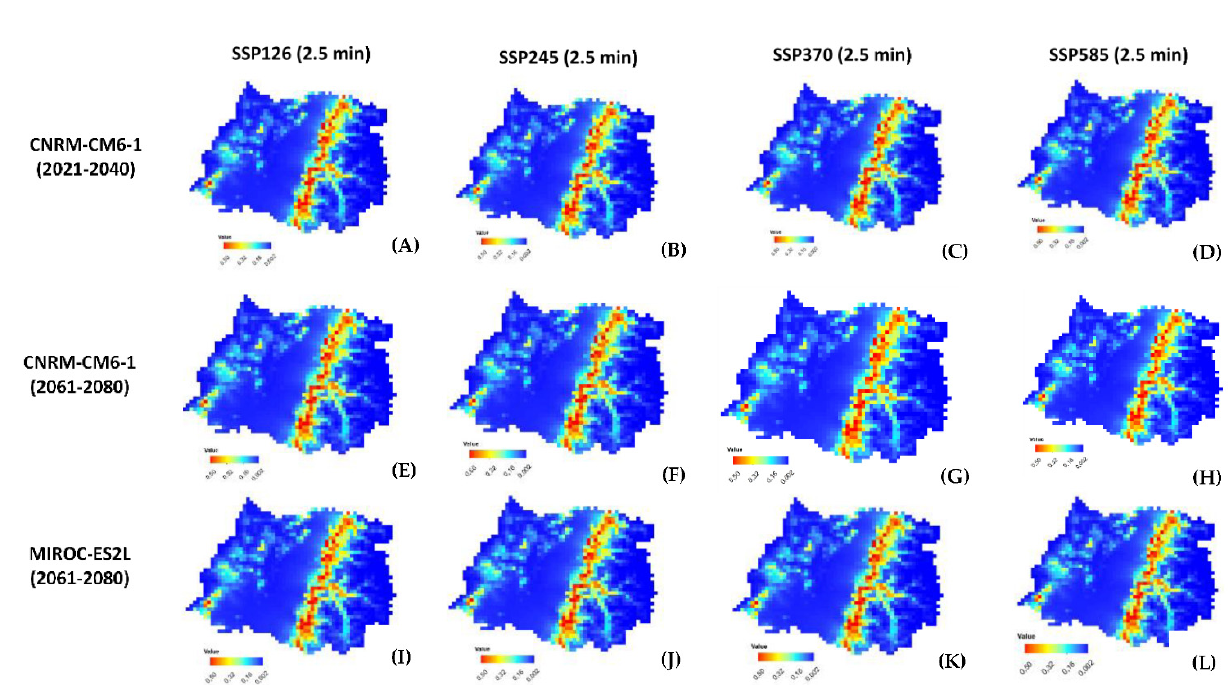
Figure 5. Ecological niche modeling of G. avellana in Maule Region based on the predicted climate change of two global climate models (GCMs): CNRM-CM6-1 and MIROC-ES2L and four Shared Socioeconomic Pathways (SSPs): 126, 245, 370, and 585 over 20 year periods (2021–2040; 2061–2080), while closest to “0.5”, the highest is the suitability for G. avellana (AUC = 0.918).